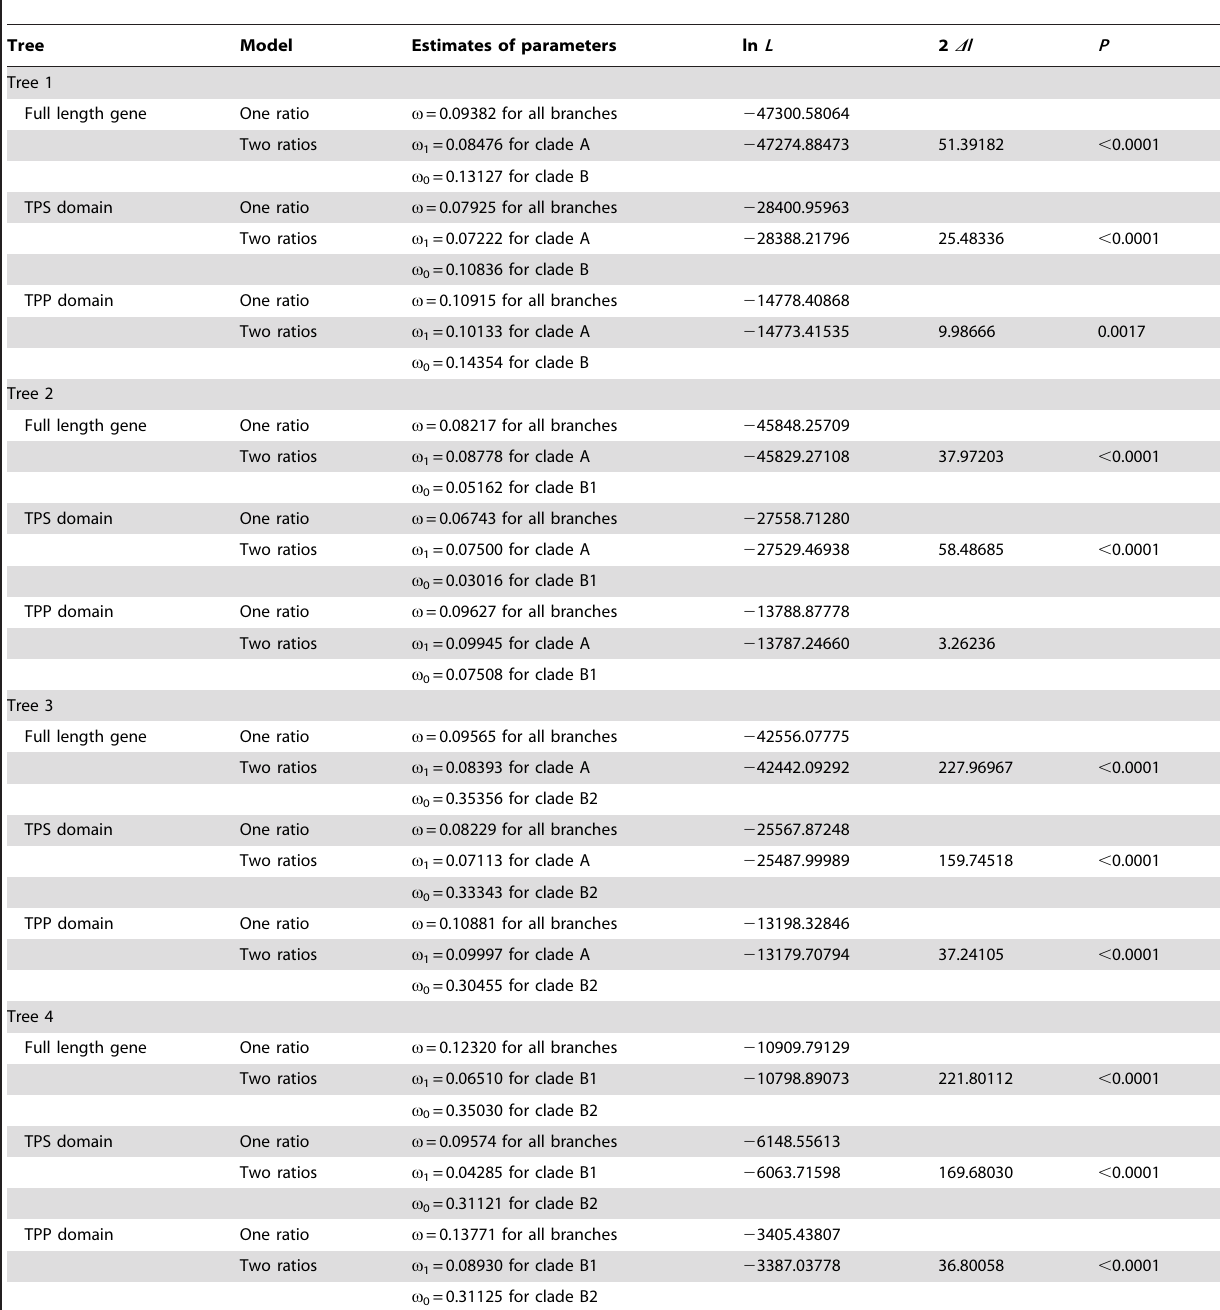
Table 1. Summary statistics for detection of selection using branch specific models of